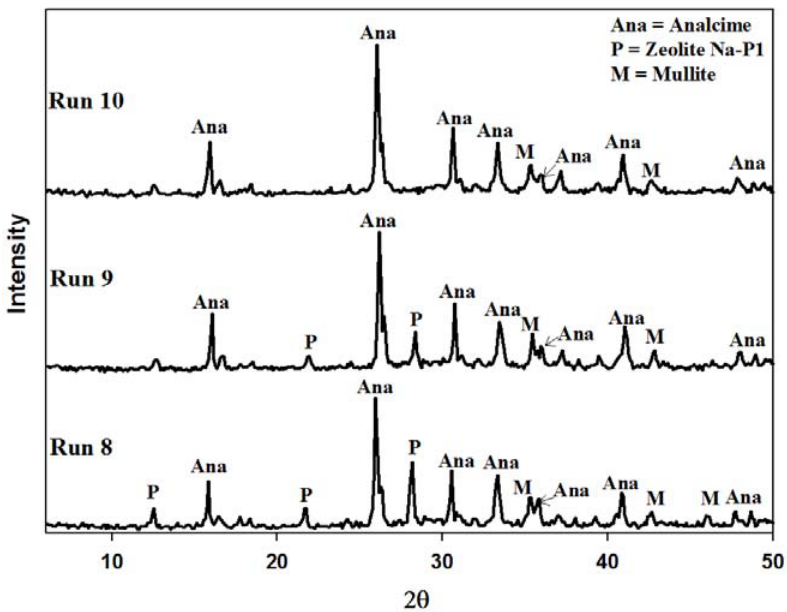
Figure 11. XRD patterns illustrating reproducibility of results depicted in figure 8 (Second results